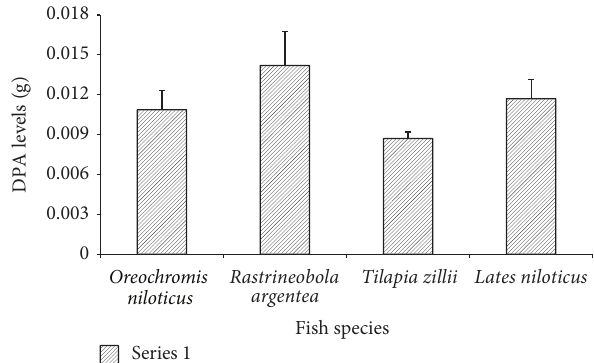
Figure 4: The DPA levels in the four commercial fish species.